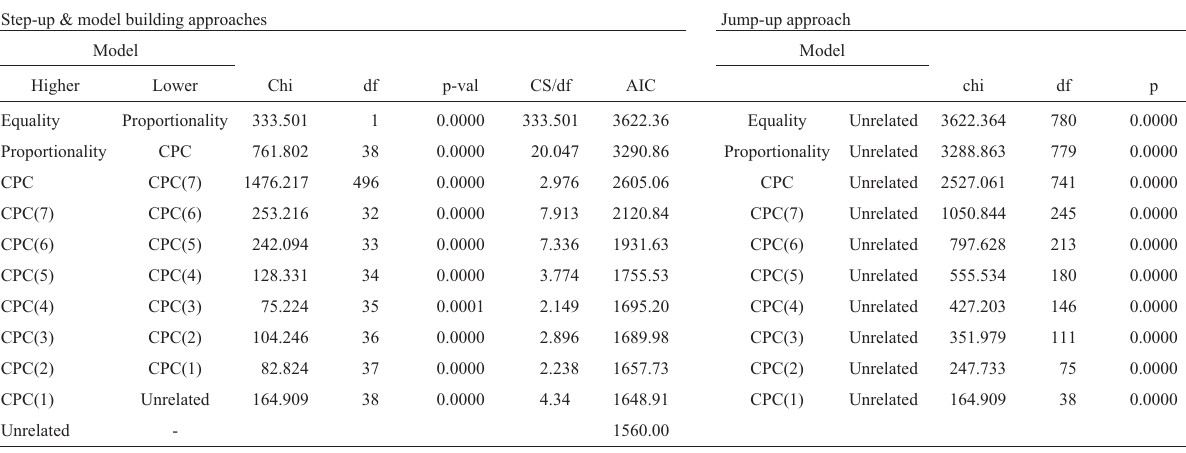
Table 3 - CPC hypothesis testing results for Saguinus-Callithrix comparison.